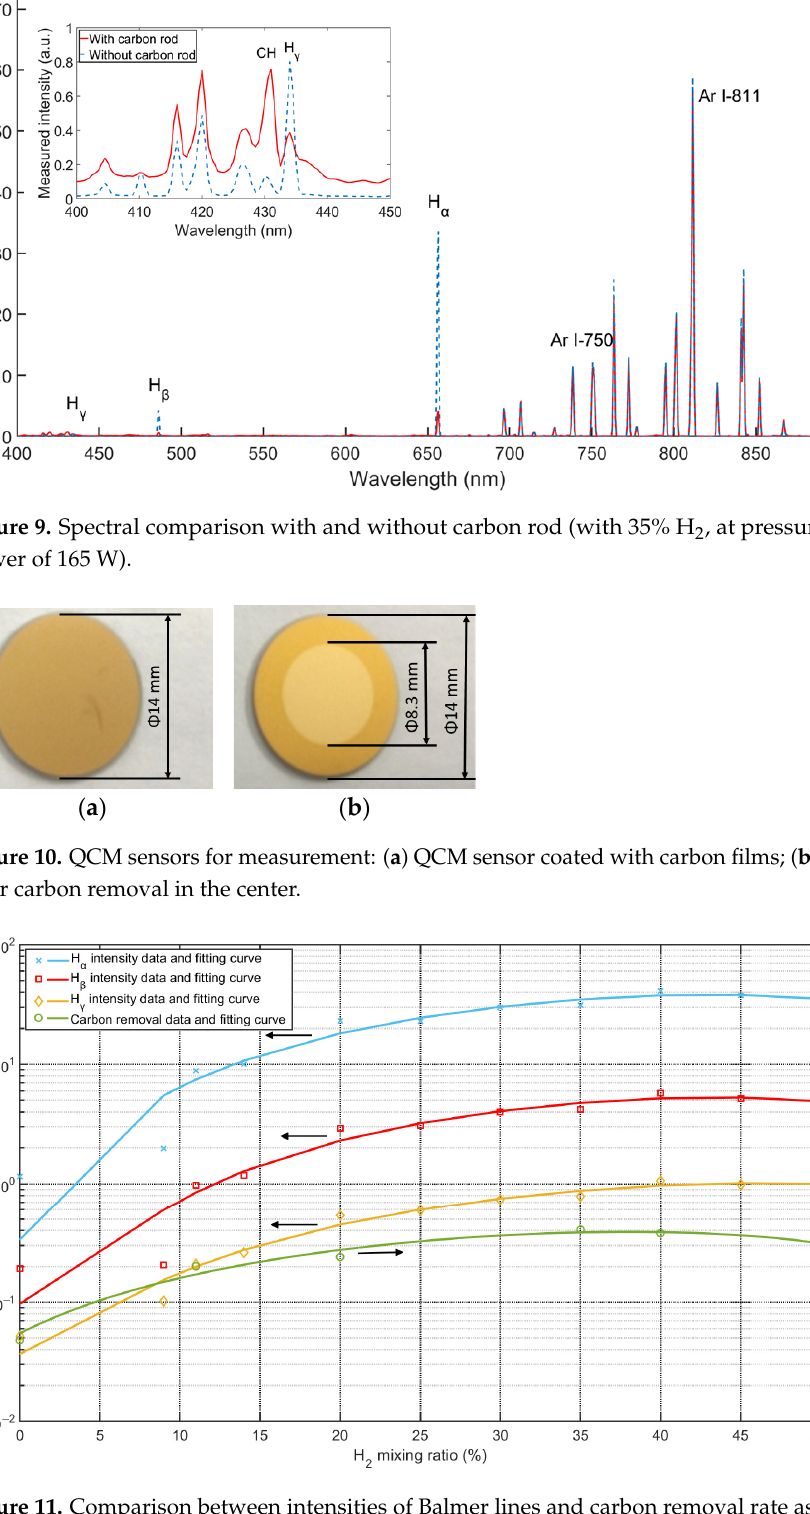
Figure 11. Comparison between intensities of Balmer lines and carbon removal rate as a function of Ar/H 2 mixing ratio.